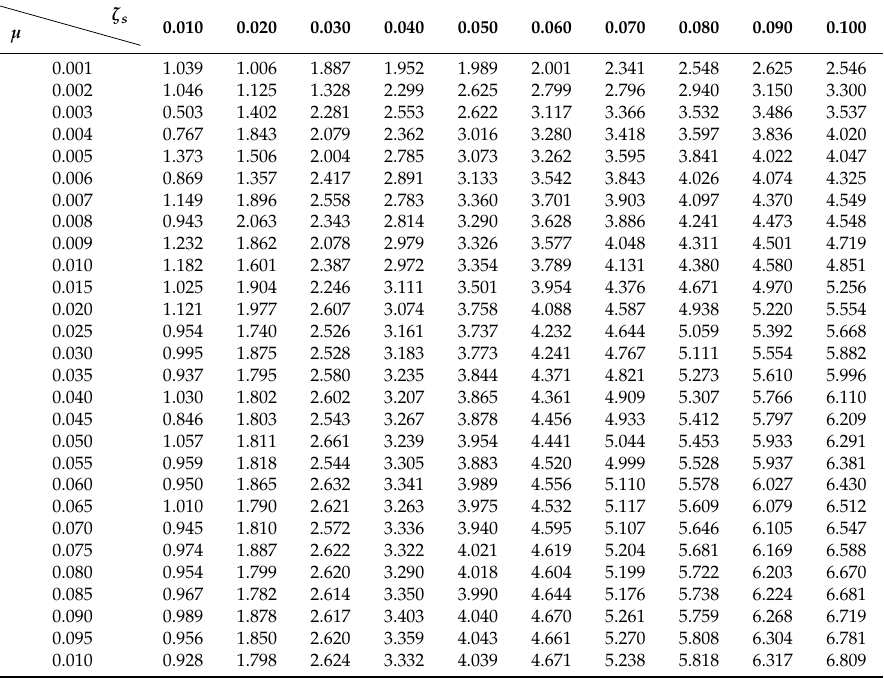
Table 2. Reduction ratio compared to the classical Den Hartog